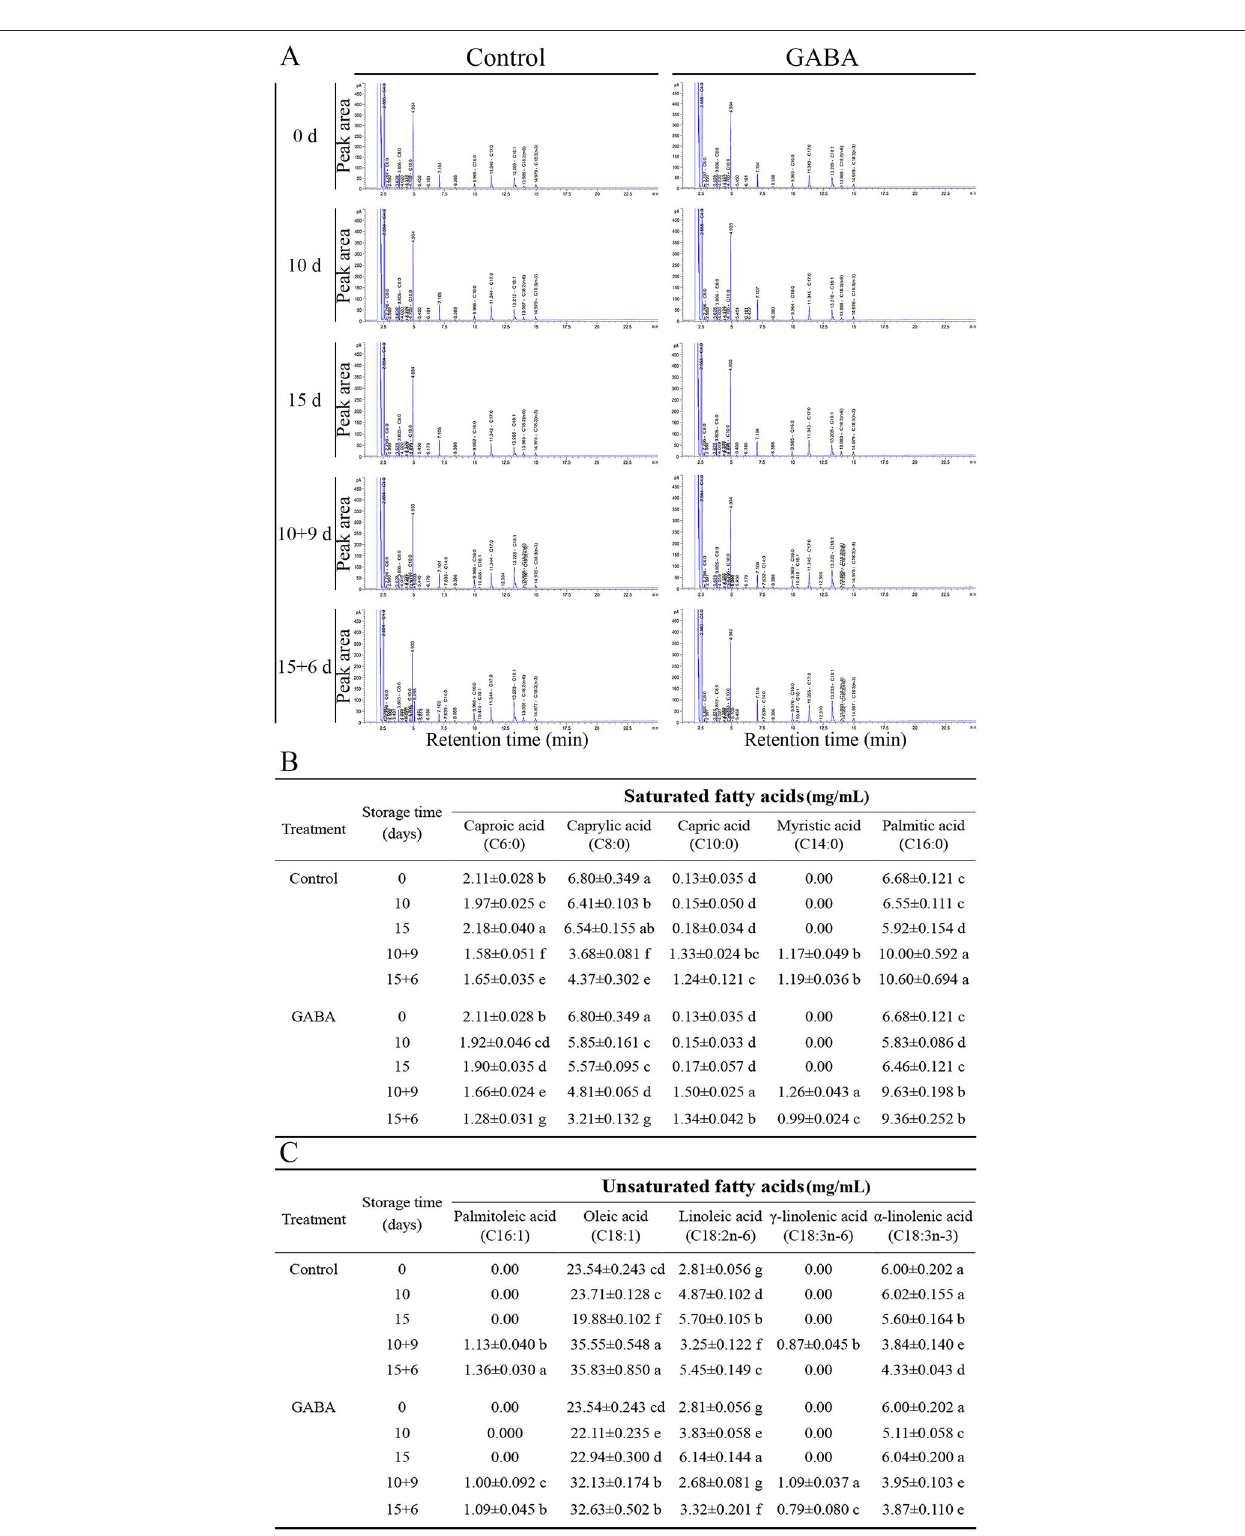
Frontiers in Nutrition |